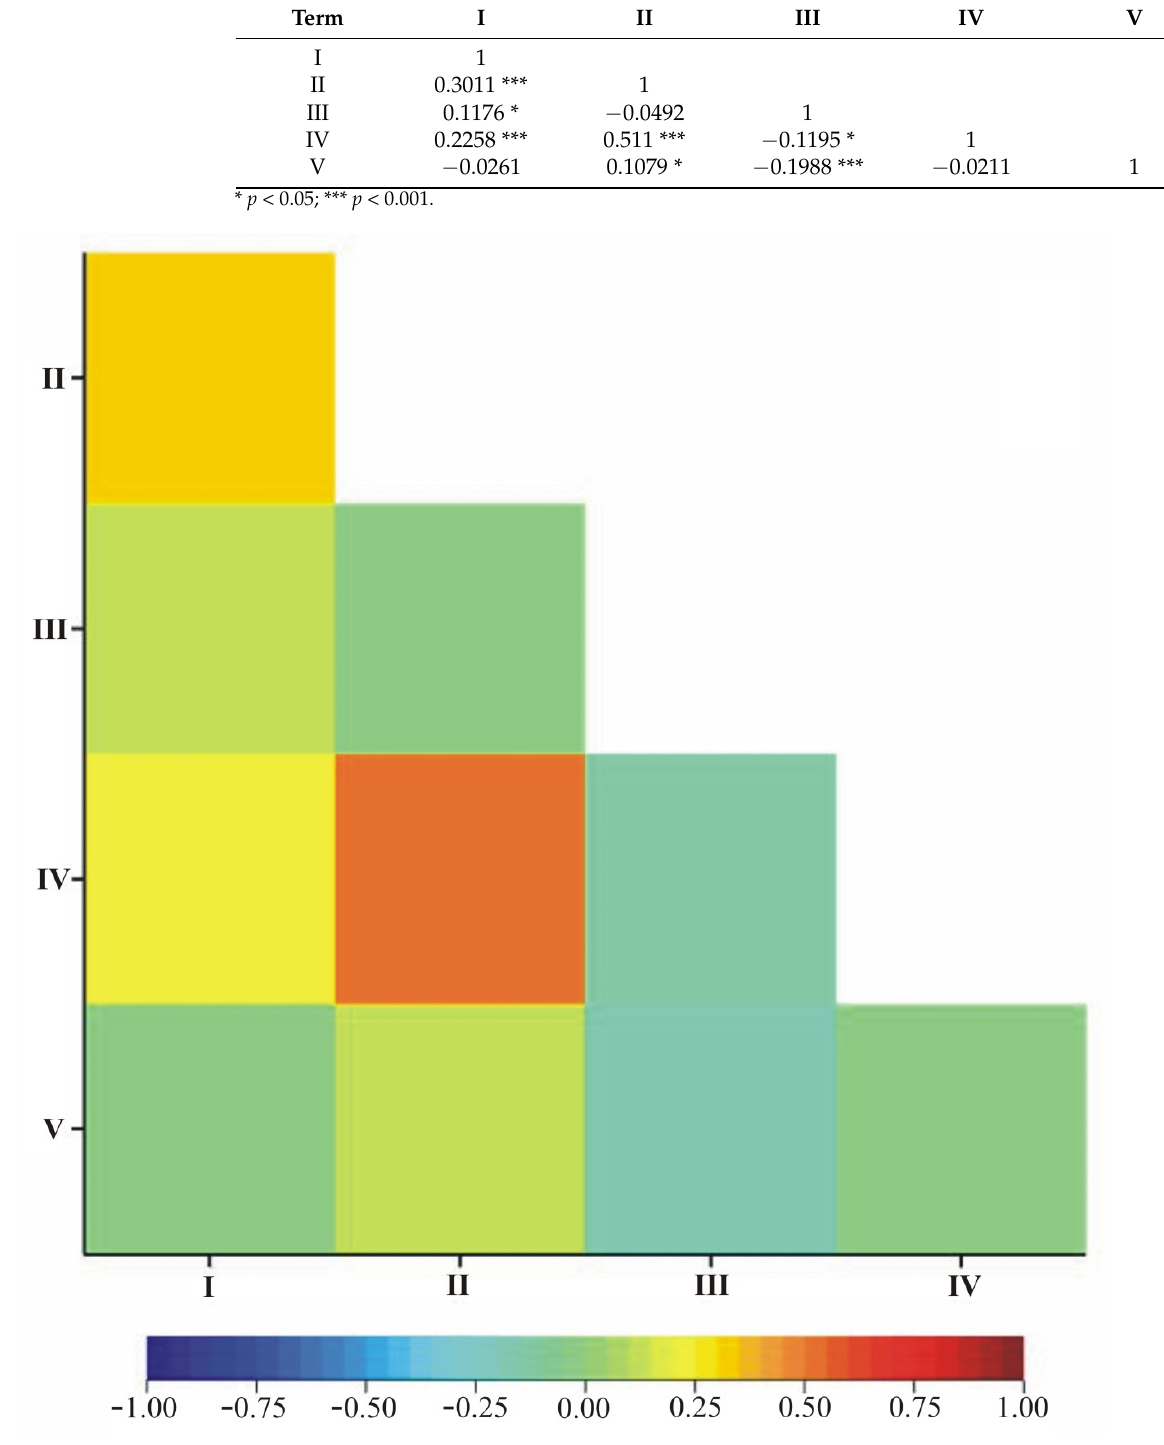
Figure 8. Heatmaps for linear Pearson’s correlation coefficients between Mahalanobis distance, estimated for all pairs of treatments at the five terms. I—1st term—pre-sowing, II—2nd term—tillering phase (BBCH 23), III—3rd term—second node (BBCH 32), IV—4th term—heading (BBCH 55), and V—5th term—post-harvest.